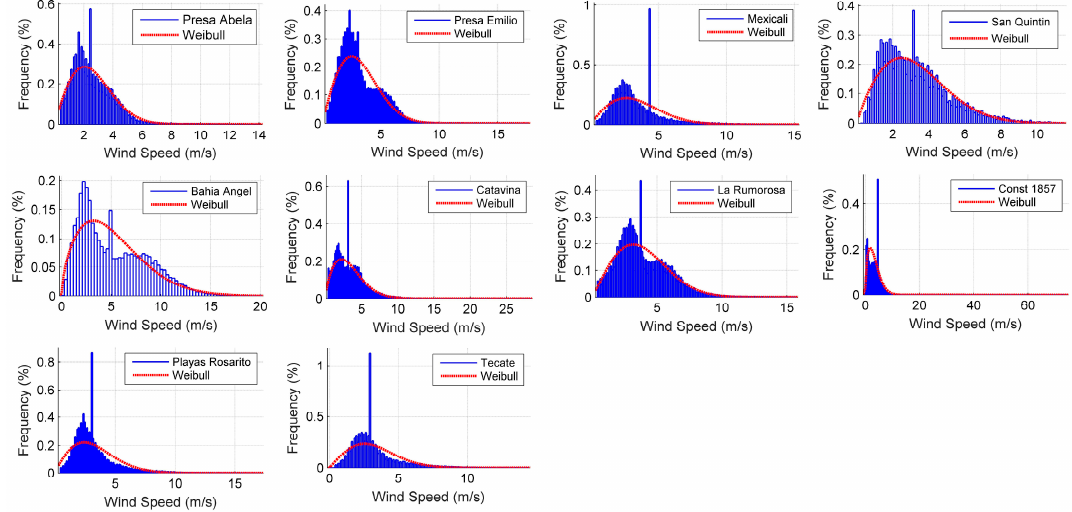
Figure 4. Weibull function at AMSs at Baja California.